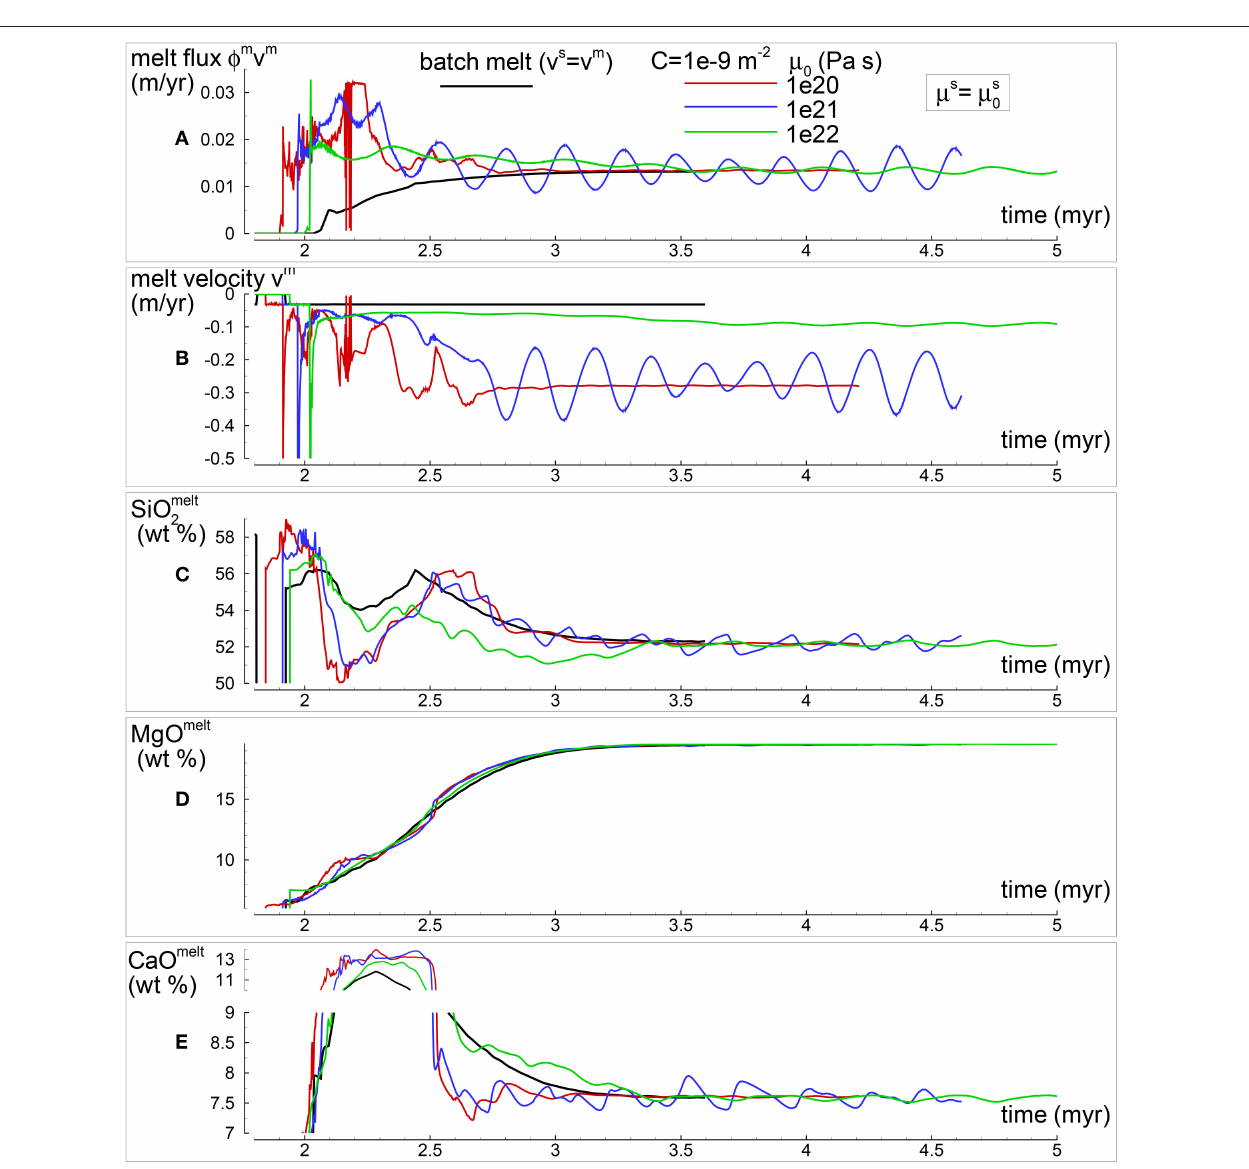
FIGURE 7 | Variation of selected melt properties over time at the top side (exit point) of the simulation for three models with µ s = µ s 0 . The permeability constant is C=10 − 9 m − 2 , µ s 0 is set to 10 20 , 10 21 , 10 22 Pa s. Results from the batch melting model are also included. (A) The melt flux ( φ m v m ) shows the amount of melt per year that is extracted from the mantle column. (B) Melt velocity (m/yr). (C) Melt composition: SiO 2 (wt %). (D) Melt composition: MgO (wt %). (E) Melt composition: CaO (wt %). Complete data can be found in PHASE3-P.BRC4-5.DAT , PHASE3-P.YRC7.DAT , PHASE3-P.YRC4.DAT , and PHASE3-P.YRC26.DAT (zip file max-front1-data.zip